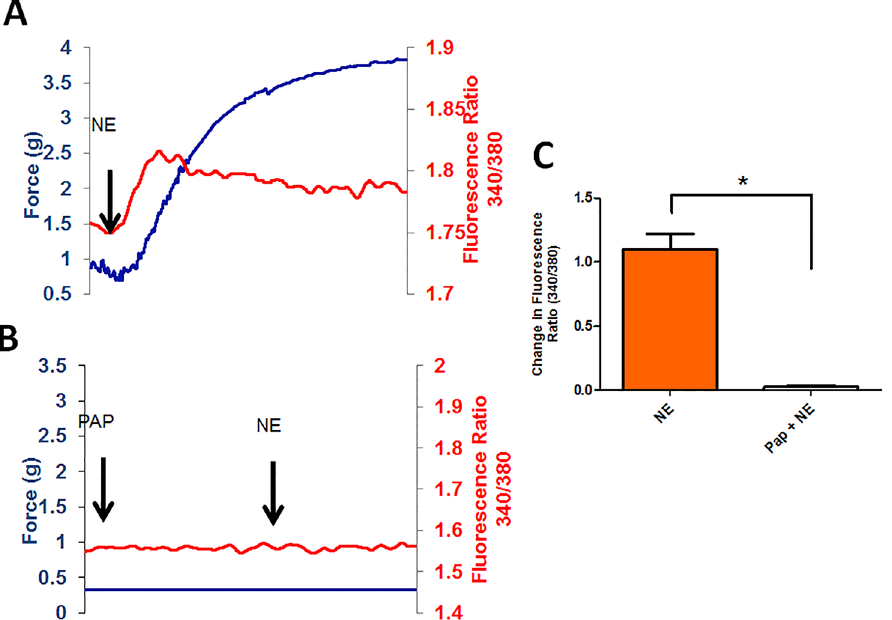
Fig 2. Pre incubation with papaverine, blocks NE induced isometric force generation (blue, Panel A and B) and intracellular Ca 2+ release (red, Panel A and B) in HSV. HSV was suspended on a Fluroplex apparatus and loaded with Fura-2AM for 4 hrs, then treated with either norepinephrine alone or papaverine (1mM) pretreatment followed by norepinephrine. Tissue treated with papaverine had significantly lower changes in fluorescence ratio (N = 3, * Significant compared to NE, p < 0.05 Panel